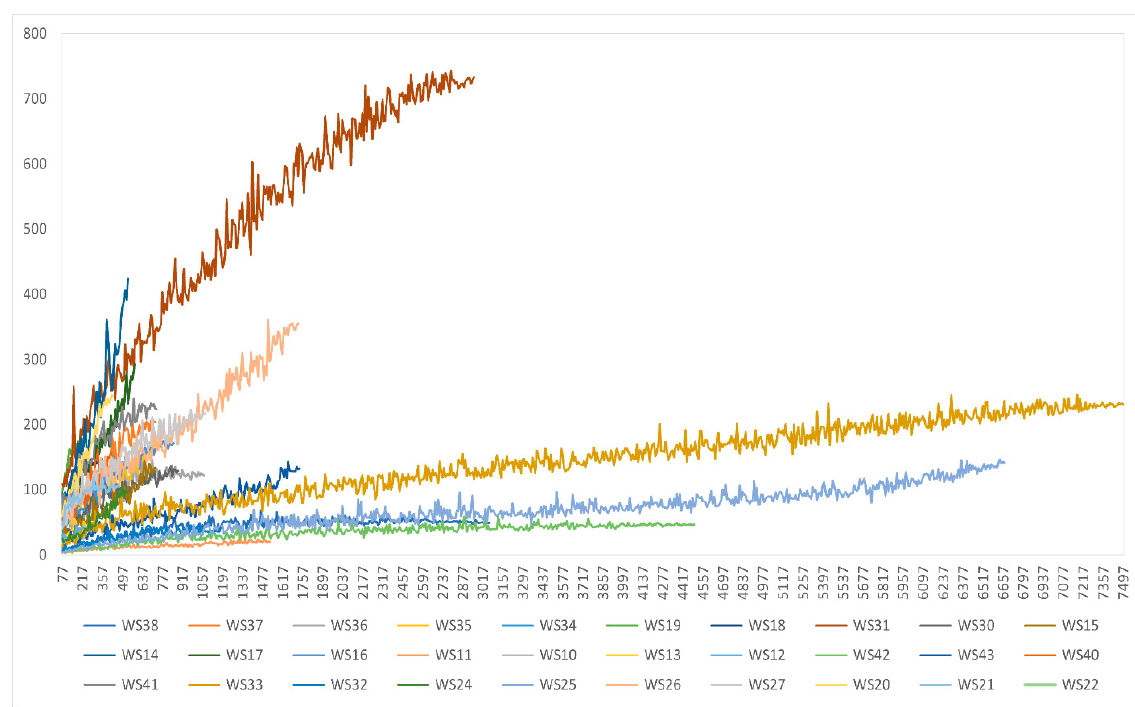
Figure 5. Chao1 indices of the alpha diversity of sequence reads WS1–WS42 corresponding to WaMS samples from 2011–2012. Sequence reads are shown on the vertical axis, with Chao1 diversity values on the horizontal axis.